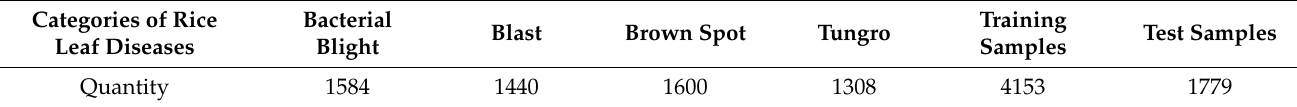
Table 1. Number of rice disease